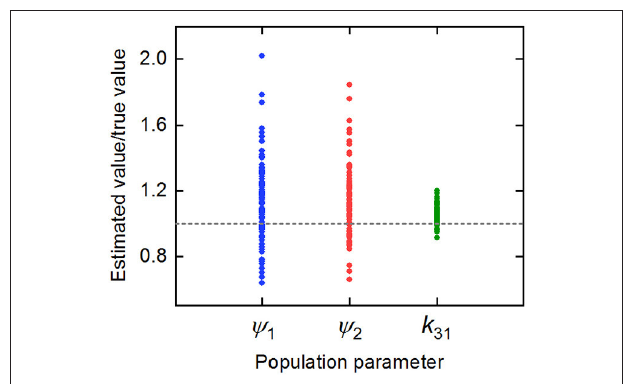
FIGURE 7 | Parameter estimates for k 31 , ψ 1 , and ψ 2 divided by the true parameter value.